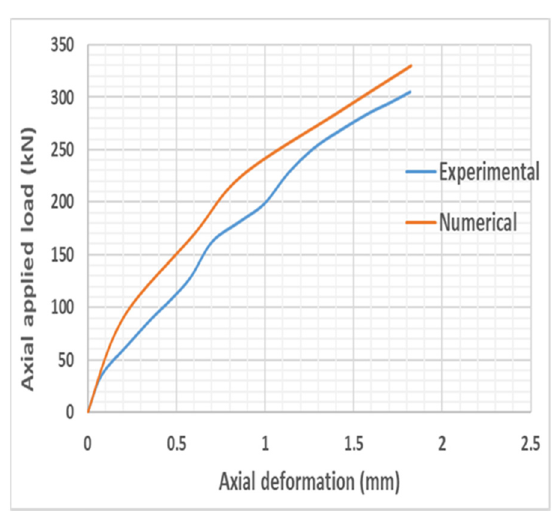
Table 2: Stress – strain expression [ 16 ]